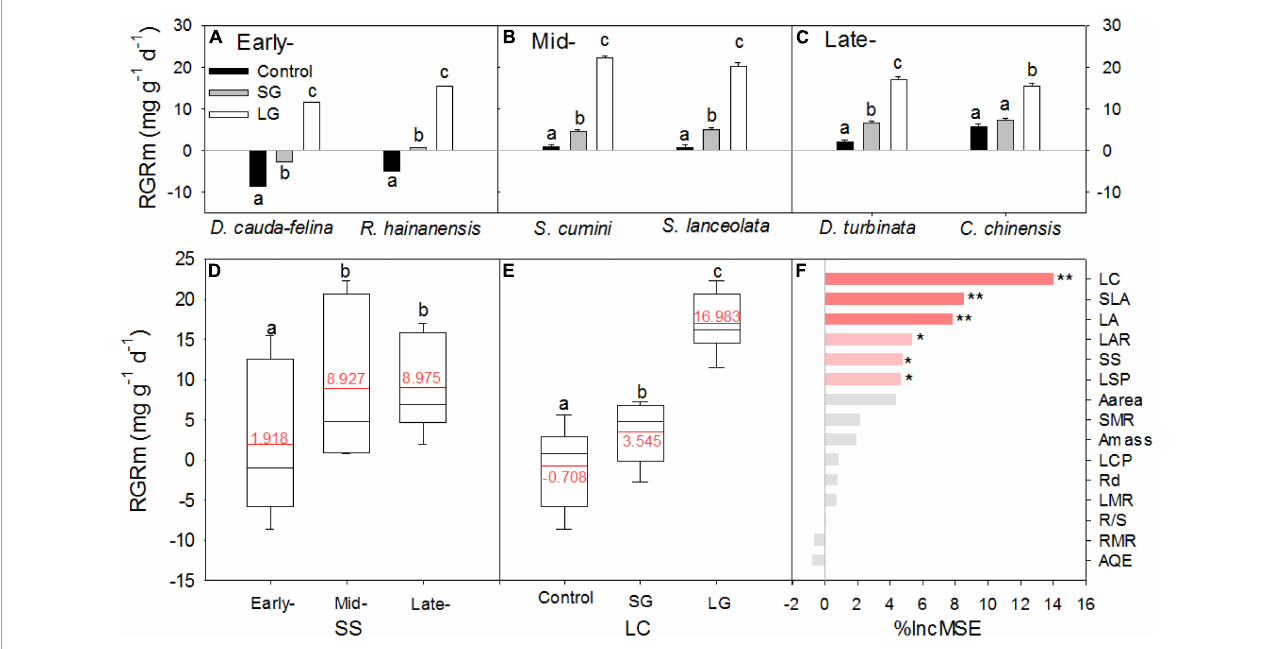
FIGURE1 Relative mass growth rate [RGR m , (A–D) ] for tree seedlings at early– (A,D) , mid- (B,D) and late-successional stage (C,D) , and in light conditions of Control, SG and LG (E) , and the importance of predictor variables for RGR m in random forest modelling (F) . Control, 0–5% of full sunlight; SG: small canopy gaps, 10–15% of full sunlight; LG: large canopy gaps, 40–50% of full sunlight. The red lines and figures in plots (D,E) are the mean value of RGR m in each group. LC, SLA, LA, LAR, SS, LSP, LCP, A area , A mass , SMR, R d , LMR, R/S, RMR, and AQE in panel (F) were abbreviations of light condition, specific leaf area, leaf area, leaf area ratio, successional stage, light saturation and compensation point, area- and mass- based light saturated rate of CO 2 assimilation, stem mass ratio, dark respiration, leaf mass ratio, root: shoot ratio, root mass ratio, and apparent quantum efficiency, respectively. In random forest modeling, “1,” “2,” and “3” were assigned to treatments of Control, SG and LG; and species at early-, mid-, and late-successional stage, respectively. %IncMSE is the per cent increase in mean squared error. Error bars and the different letters in plots (A–E) are standard error ( n = 25) and significant difference at P < 0.05, respectively. Symbols ** and * in plot (F) indicates statistical significance at P < 0.01 and 0.05,